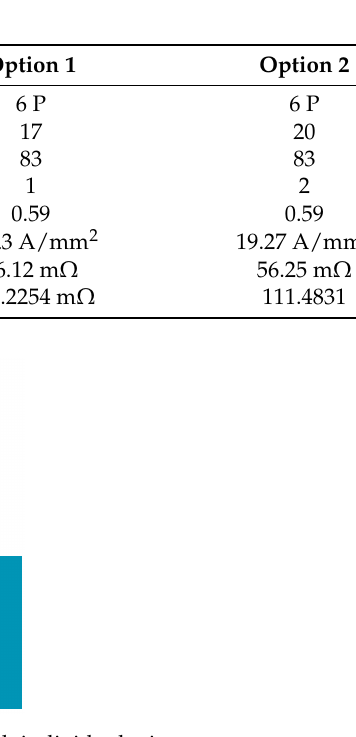
Figure 9. Conversion of stranded coil region to coil with individual wires.